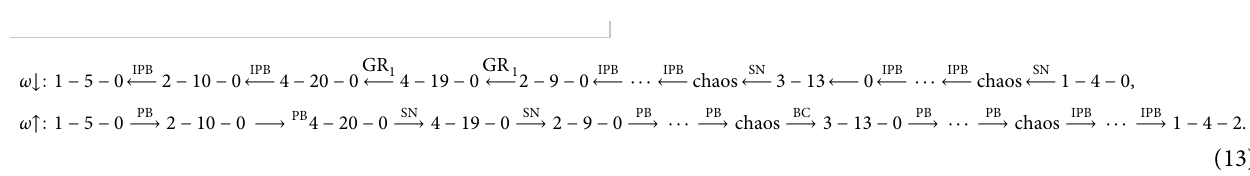
� 0 . 39347. (b) ω � 0 . 39357. (c) ω � 0 . n . (a) ω